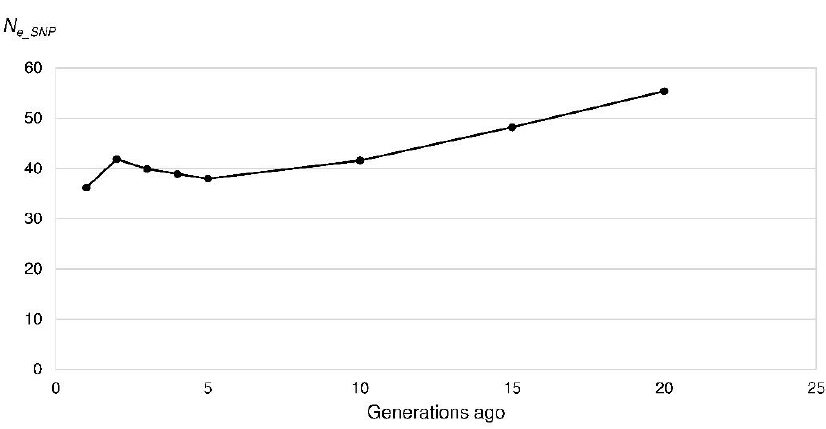
Figure 7. Effective population size ( N e_SNP ) of the Polish Lowland Sheepdogs in the last 20 generations based on the linkage disequilibrium among single nucleotide polymorphism (SNP) alleles per chromosome.